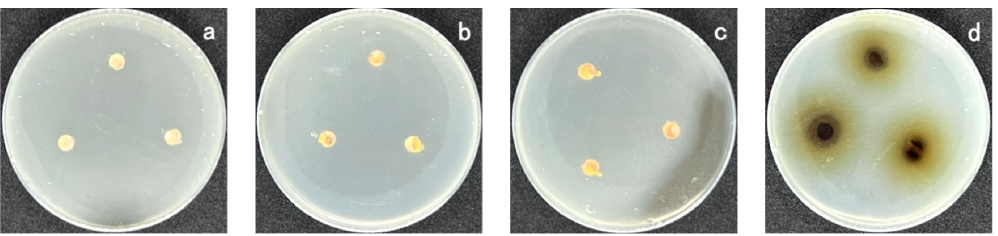
Figure 1. Inhibition of steam distillation extract ( a ), n-hexane extract ( b ), petroleum ether extract ( c ), and ethanol extract ( d ) on Escherichia coli .